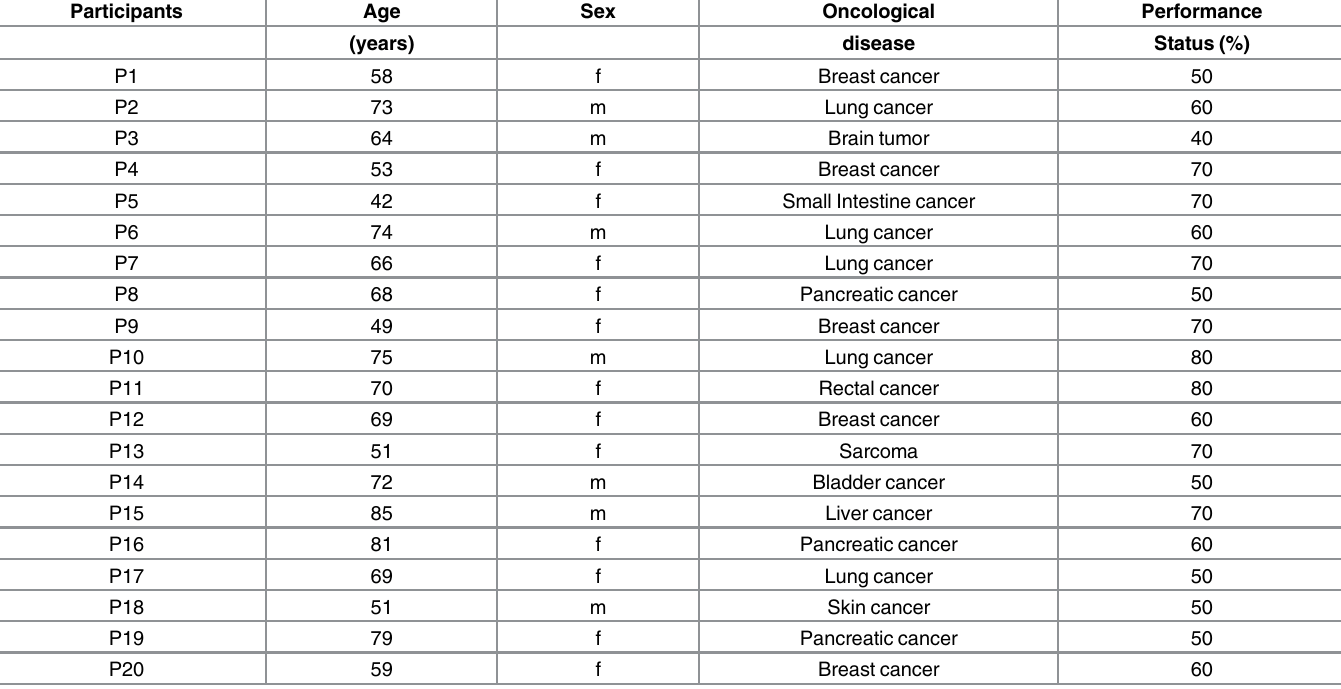
Table 2. Profile of the Study Participants.